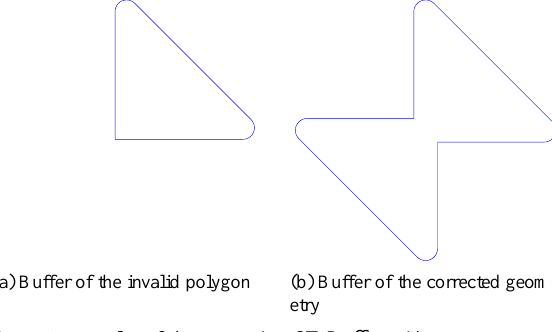
Figure 2: Results of the operation ST Buffer with a parameter of 0 . 1